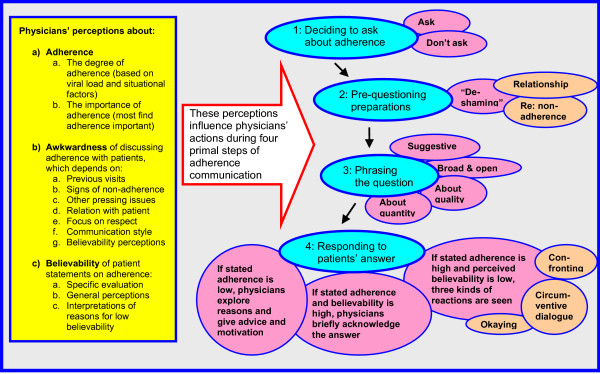
Model of physicians' adherence communication (expanded version). Physicians go through four steps when communicating with patients about adherence. The way physicians act in these is markedly influenced by three aspects of their perceptions. Each of the four steps has its subcategories, and each of the three perceptions has its main determinants (see figure 1 for a simple version of the model).